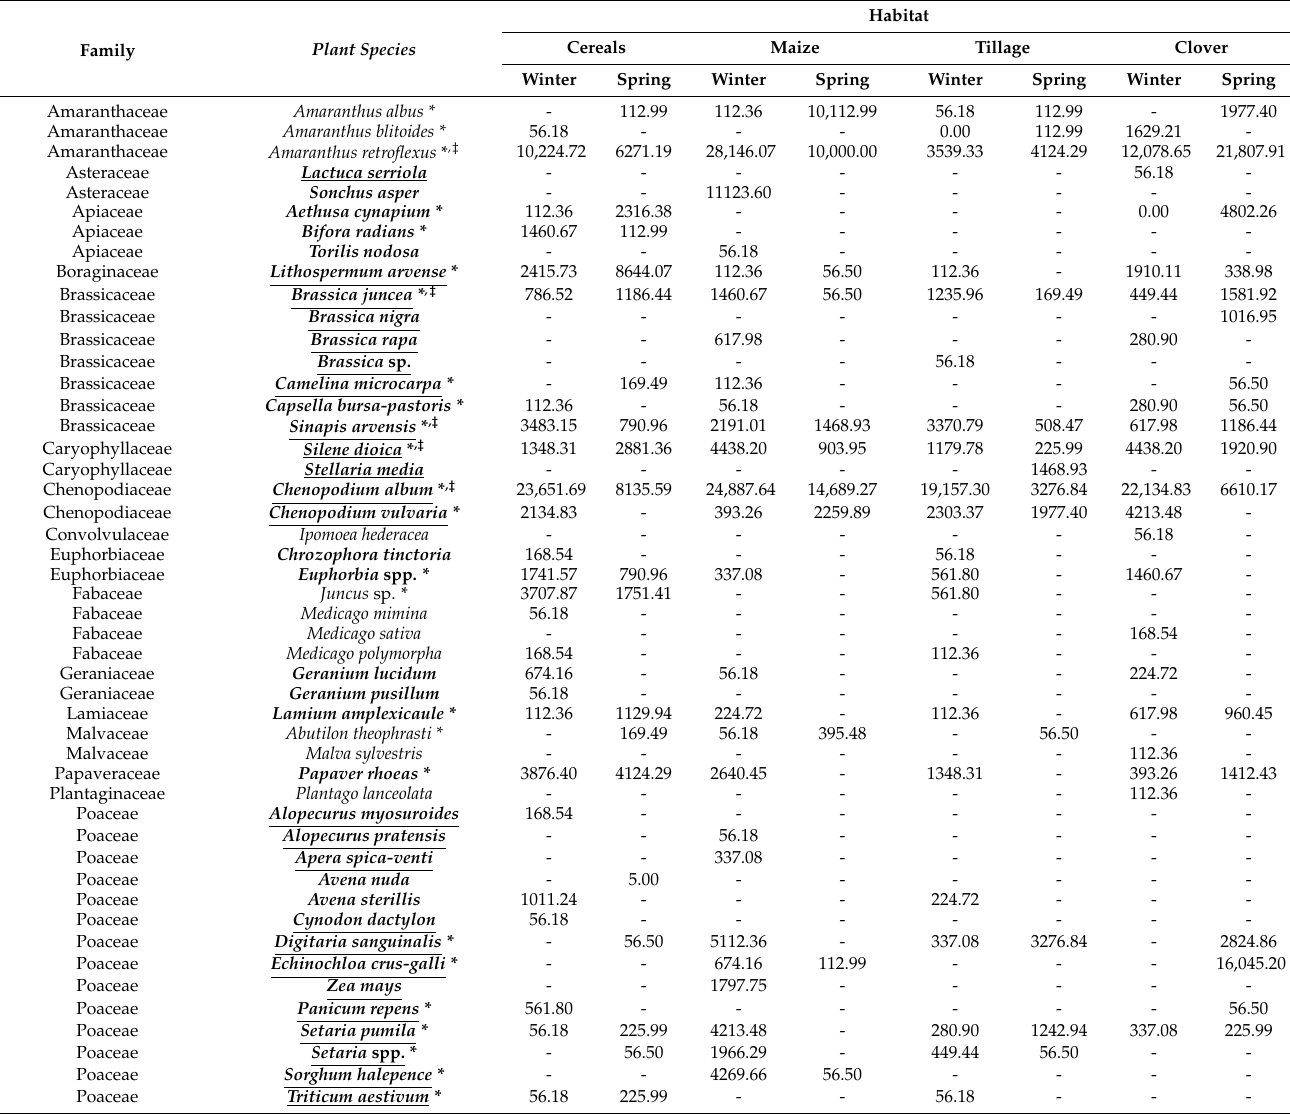
Table A5. The total number of seeds per m 2 estimated for each species of the topsoil seedbank in each studied habitat for winter (left columns) and spring (right columns),